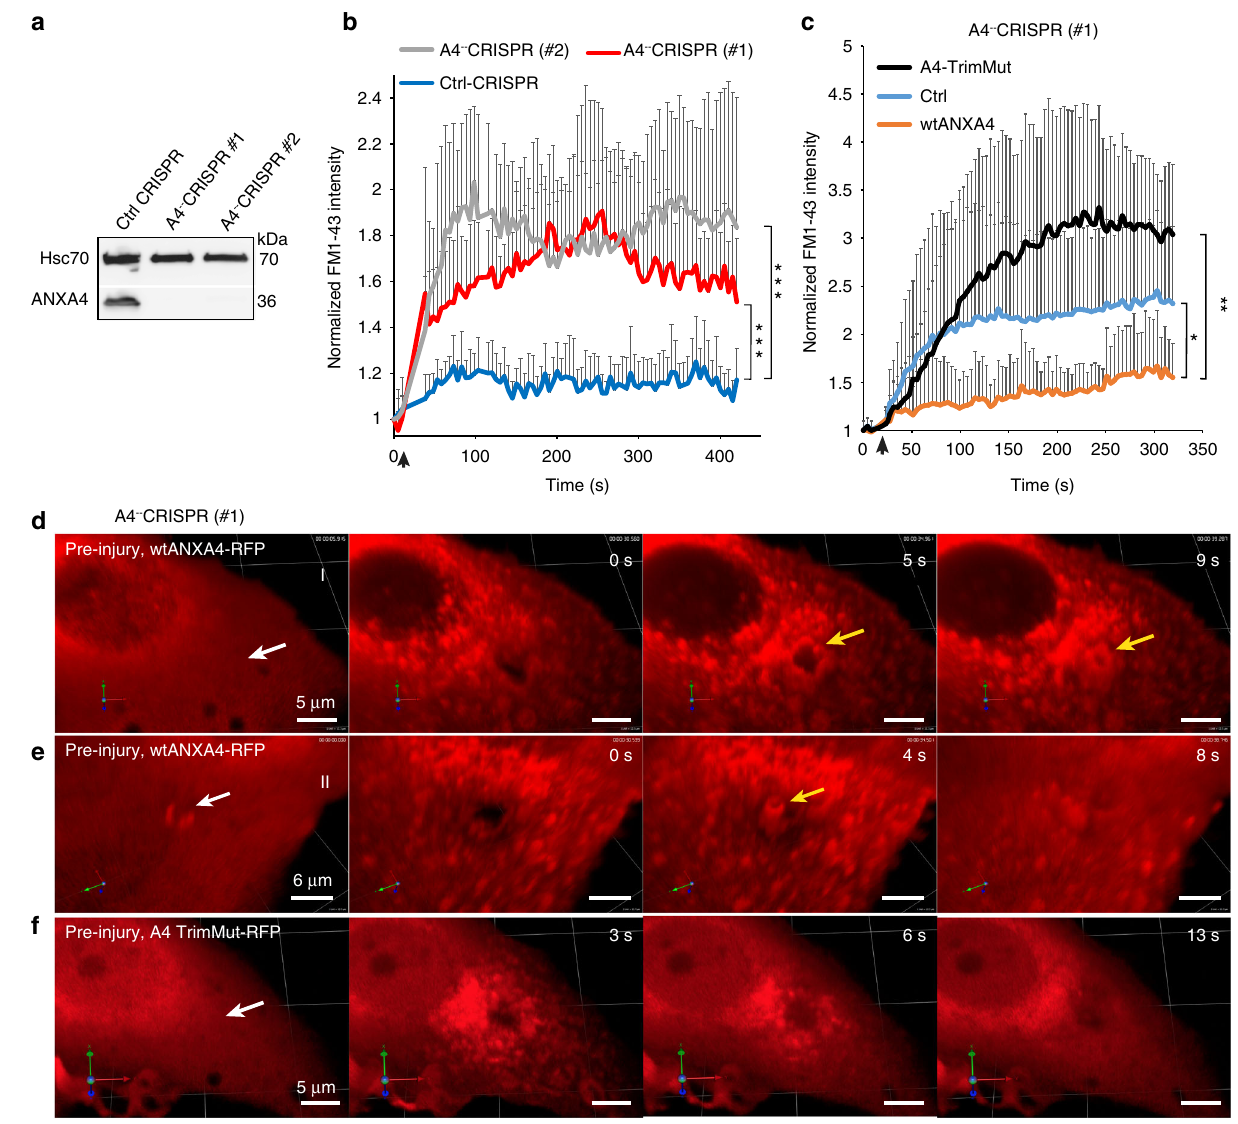
Fig. 2 ANXA4 is needed for repair in MCF7 cells. a Immunoblot of lysates from MCF7A4 − -CRISPR cells with disrupted ANXA4 gene expression. Hsc70 served as internal control for equal loading. b Plasma membrane repair kinetics upon laser injury measured by membrane impermeable FM1-43 dye in fl ux in b CRISPR clones and in c MCF7A4 − -CRISPR (#1) cells expressing wild-type ANXA4-RFP, ANXA4 TrimMut-RFP or Ctrl-RFP. Error bars represent S. D. for at least eight independent cells per condition. P values based on t -test: * P ≤ 0.05, ** P ≤ 0.01. d Sequential 3D images of MCF7A4 -- -CRISPR (#1) with reintroduced ANXA4-RFP and exposed to a large injury by shooting through the cell by laser (injury site marked by white arrow). ANXA4-RFP translocation to wound edges and constriction is marked by yellow arrow (also, see Supplementary Movie 1). e Example of ANXA4-RFP-induced curvature and funnel formation (yellow arrow) created from the bottom of the plasma membrane after laser injury. f Trimer-de fi cient ANXA4-RFP mutant (A4- TrimMut) failed to induce curvature upon laser injury (see also Supplementary Movie